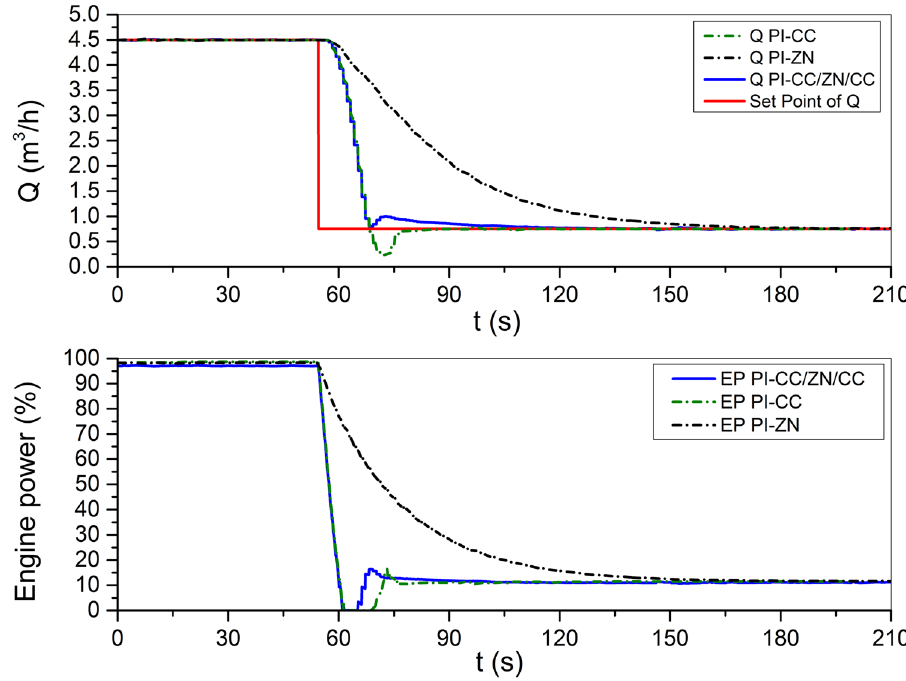
Fig. 9 Flow rate and pump power in function of time dur- ing test with auto-switch option